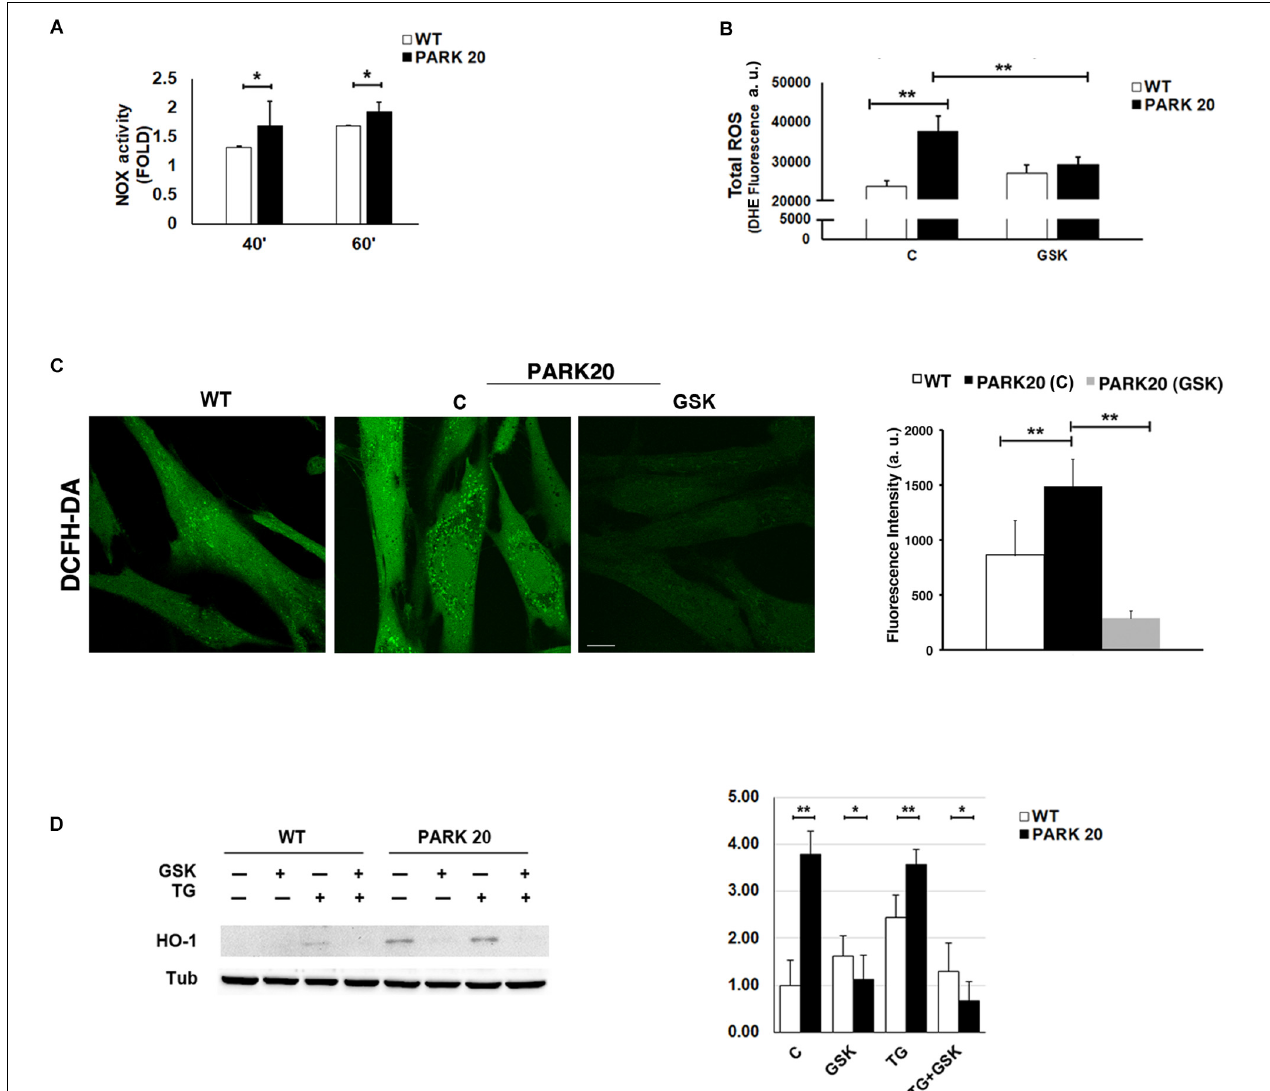
FIGURE 5 | Oxidative stress is increased in PARK20 fibroblasts. (A) NADPH oxidase (NOX) activity assay performed in HDF cells (WT) and PARK20 fibroblasts as reported in the methods. Histogram shows the relative fold change of NOX activity expressed as mean ± SD. Results were obtained from three independent experiments. (B,C) ROS quantification was carried out by using DHE (B) or DCFH-DA (C) fluorescent probes. HDF cells (WT) and PARK20 fibroblasts were untreated (C) or treated for 2 h with 1 µ M GSK2606414 (GSK) and then processed for DHE or DCFH-DA fluorescence quantification as detailed in the methods section. Histograms show mean values ± SD of DHE or DCFH-DA fluorescence expressed as arbitrary unit (a. u.) and calculated on three independent experiments. Scale bar 10 µ m. (D) Immunoblot detection of HO-1 and densitometric analysis of three independent experiments. Starved HDF (WT) and PARK20 cells were either untreated (C) or treated for 2 h with 1 µ M GSK2606414 (GSK) or 500 nM Thapsigargin (TG) alone (GSK and TG respectively) or in combination (TG + GSK) as aforementioned. α -Tubulin (TUB) was used as loading control. Representative immunoblotting is shown. Histogram shows the relative fold induction of HO-1 expression in the treated samples compared to the control samples. Results are expressed as mean values ± SD. ∗ p ≤ 0.05, ∗∗ p ≤ 0.01, Student’s t